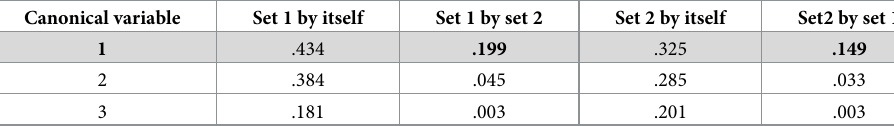
Table 14. Variance explained canonical correlation.